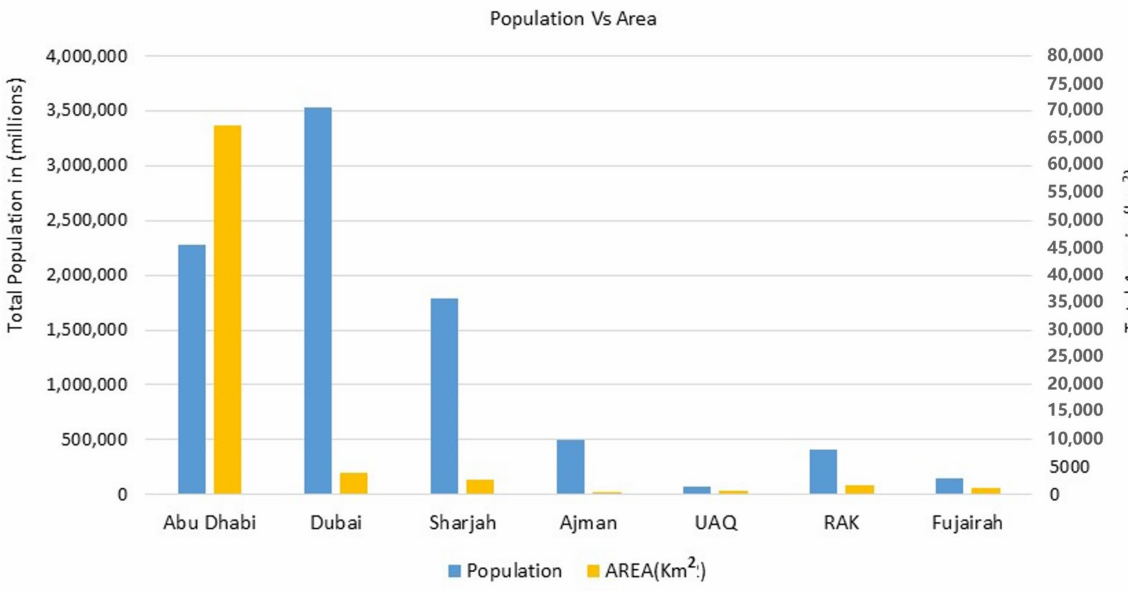
Figure 4. Bar graph indicating total population of each emirate vs. total area of each